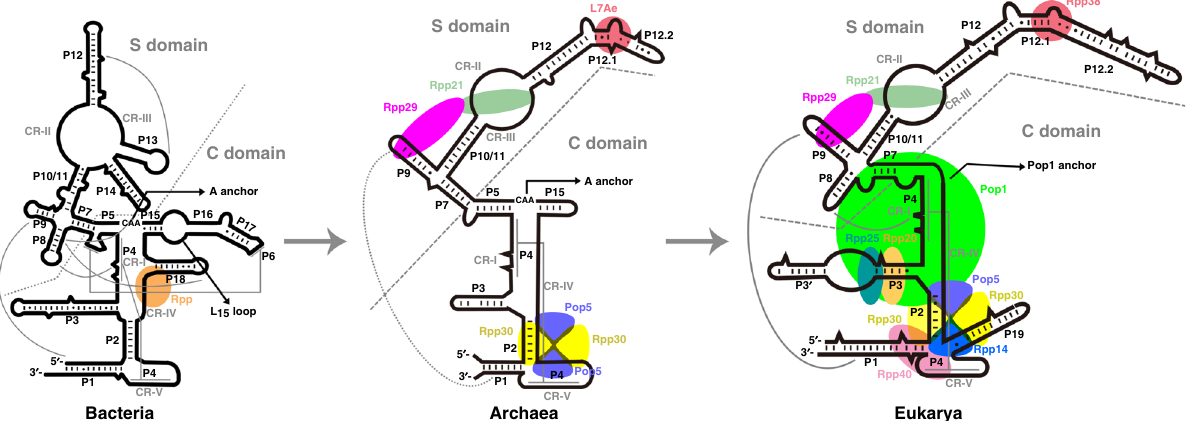
Fig. 9 A evolution model of RNase P from bacteria to archaea, and to eukarya. Secondary structure models of T. maritima , M. jannaschii and human RNase P RNAs are based on their atomic structures. Long-range RNA-RNA interactions are denoted by gray lines. Protein components are colored as in Fig. 2a and are placed in positions based on the atomic structures demonstrate that Mja RNase P is a hybrid of bacterial and eukaryal RNase Ps, with bacterial-like two RNA-based anchors but eukaryal-like protein-aided stabilization mechanism, exem- plifying that archaea are evolutionary intermediates between bacteria and eukarya. Bacterial RPR element including loop L 15 that forms speci fi c